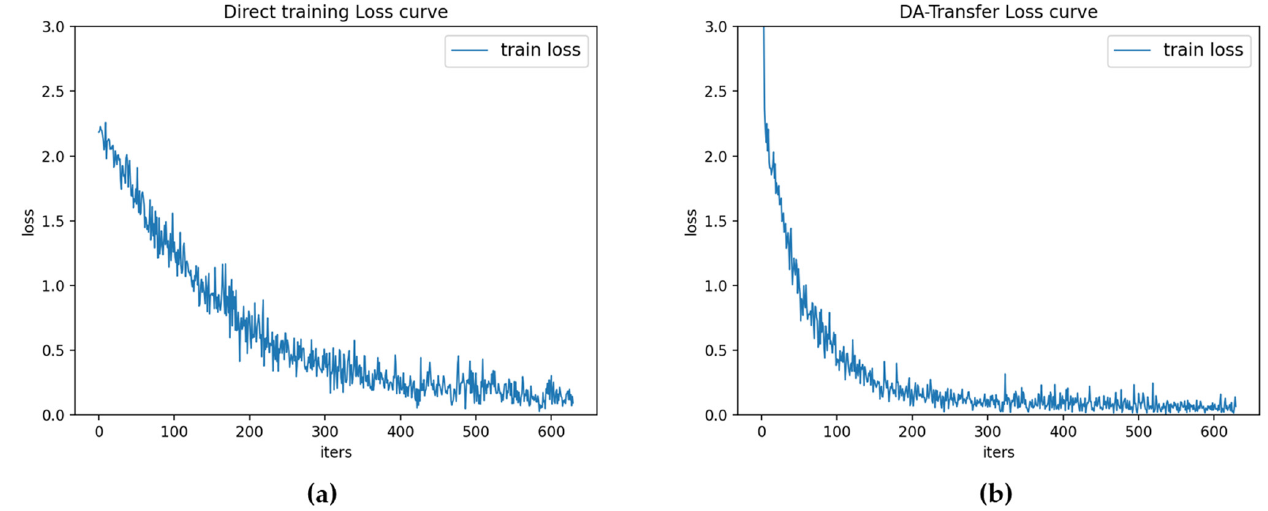
Figure 5. ( a ) The loss curve of the direct training model. ( b ) DA-Transfer model loss